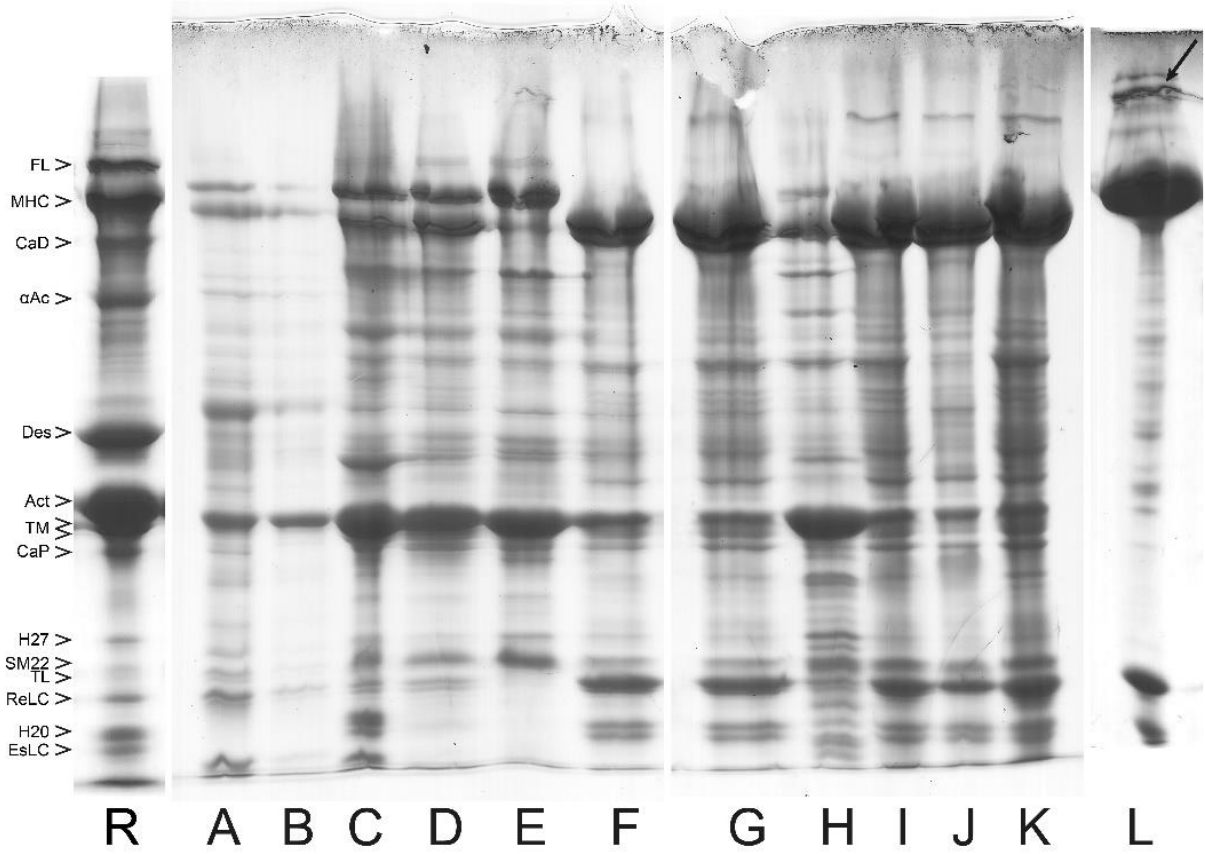
Figure 4. Purification steps of bovine tracheal smooth muscle myosin analyzed by SDS PAGE sys- tem for a small amount of starting muscle tissue (2 – 3 g). Individual bands are identified and labeled